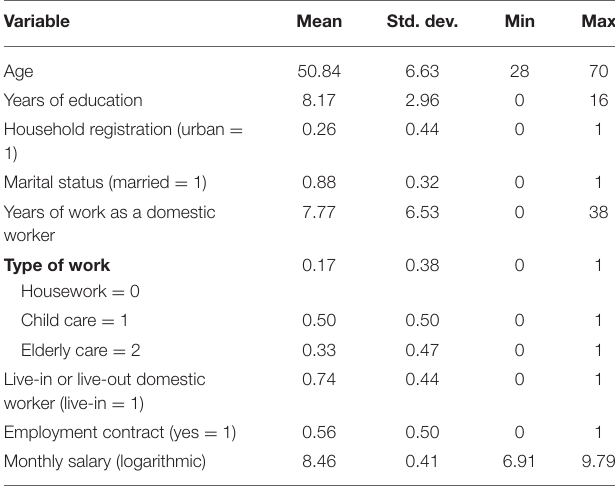
TABLE 1 | Descriptive statistics for the control variables ( N =